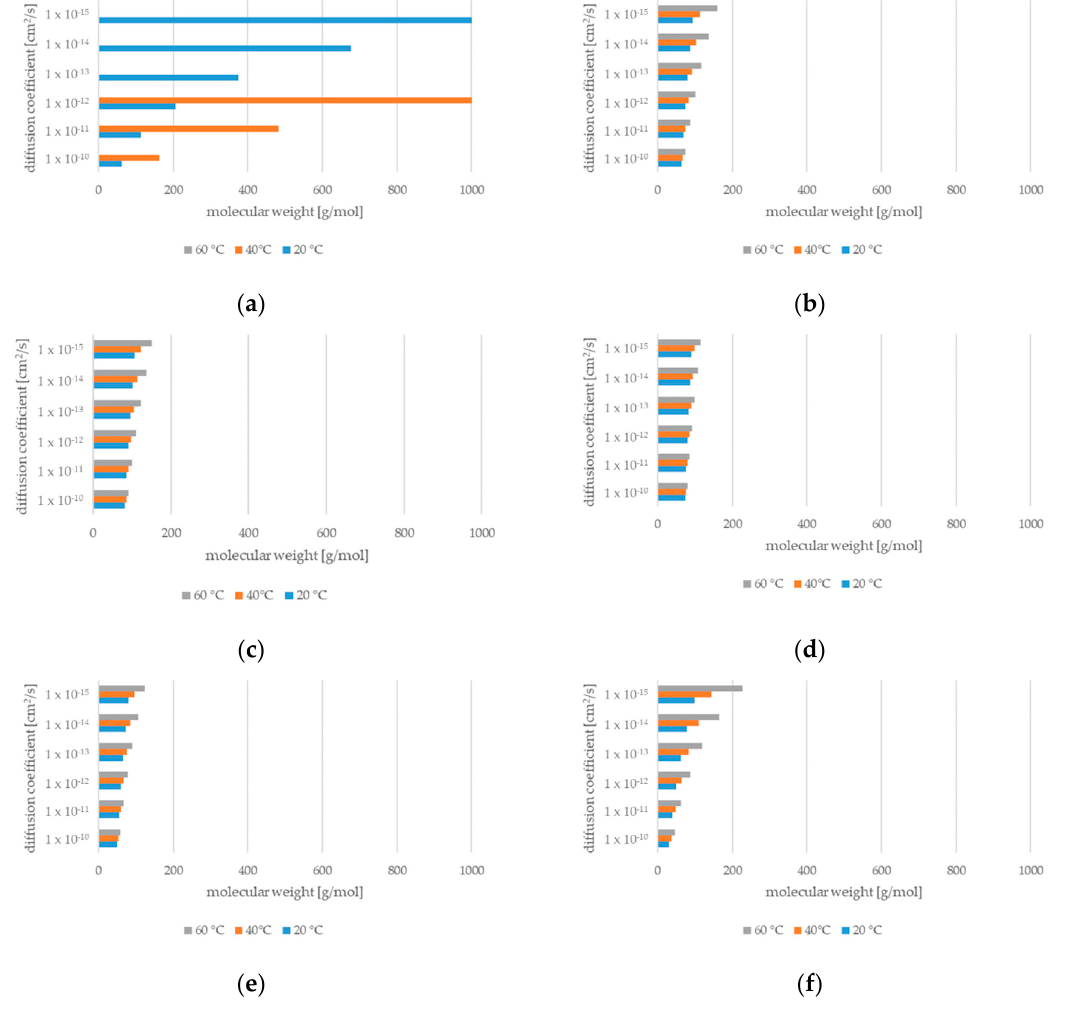
Figure 3 . Diffusion coefficients at 20 °C, 40 °C, and 60 °C in different polymers: ( a ) PP, ( b ) GPPS, ( c ) HIPS, ( d ) ABS, ( e ) Figure 3. Diffusion coefficients at 20 ◦ C, 40 ◦ C, and 60 ◦ C in different polymers: ( a ) PP, ( b ) GPPS, SAN, and ( f ) PET (without bars: molecular weight > 1000 mg/mol) ( c ) HIPS, ( d ) ABS, ( e ) SAN, and ( f ) PET (without bars: molecular weight > 1000